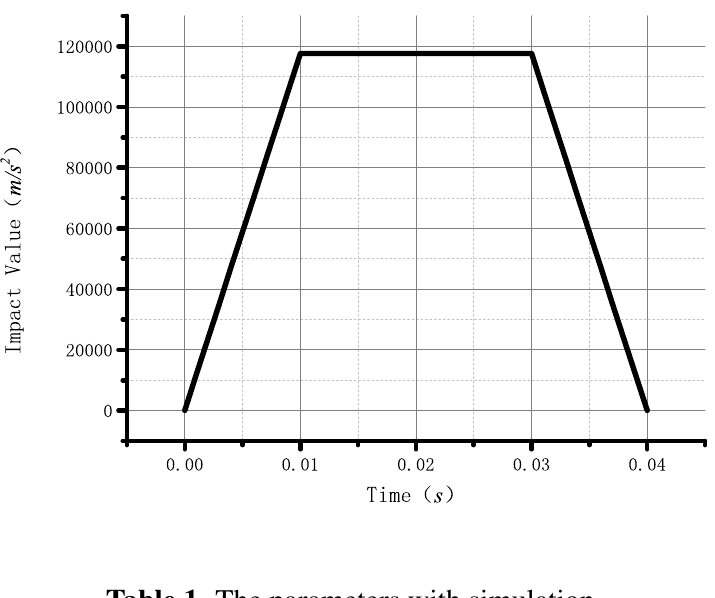
Figure 7. The diagram of impact.